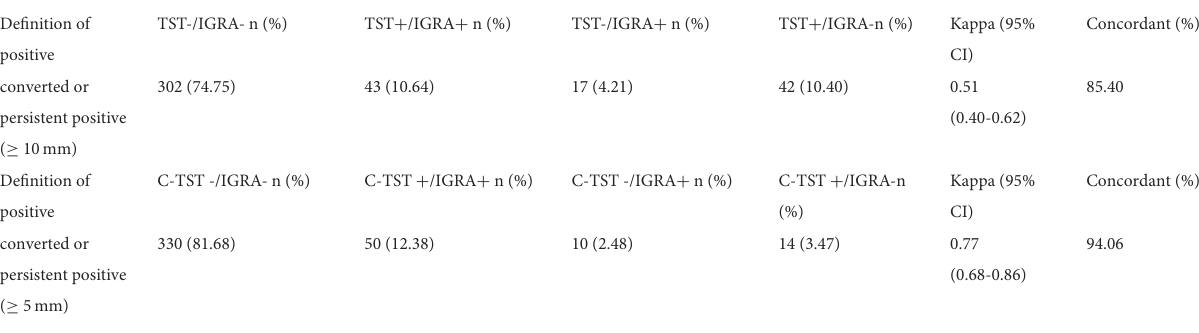
Table 5. The median level of TST and C-TST increased from 0mm to 13.5 mm and 0mm to 20mm respectively in baseline IGRA positive subgroup. At the 3-month follow-up survey, for 27 TST conversions with baseline IGRA negative results, the median level of TB1-Nil and TB2-Nil were 0.01 IU/ml (IQR: